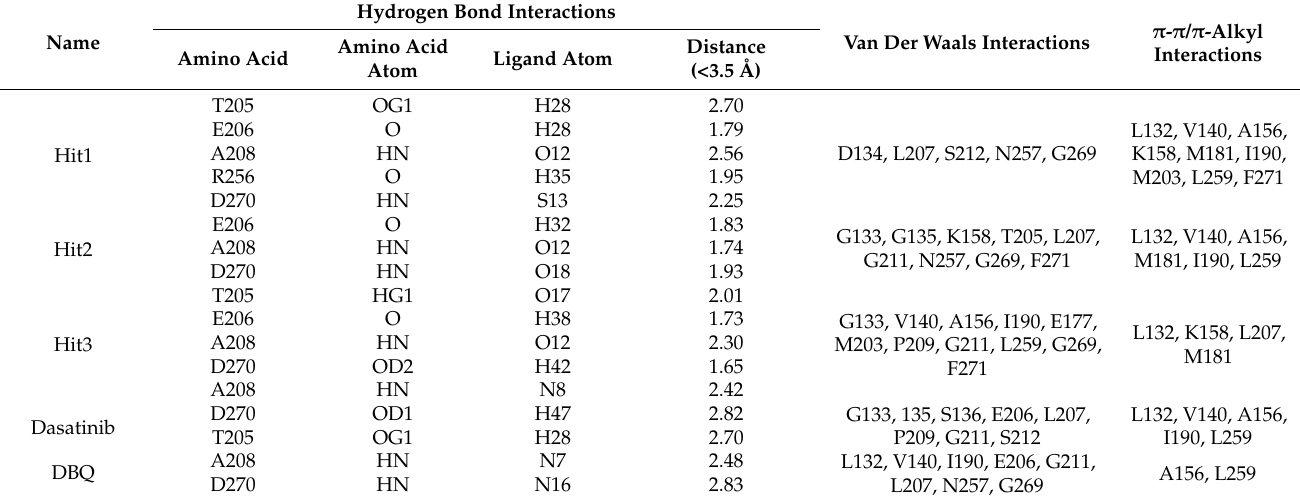
Table 4. The detailed inter-molecular interactions between Hit compounds and